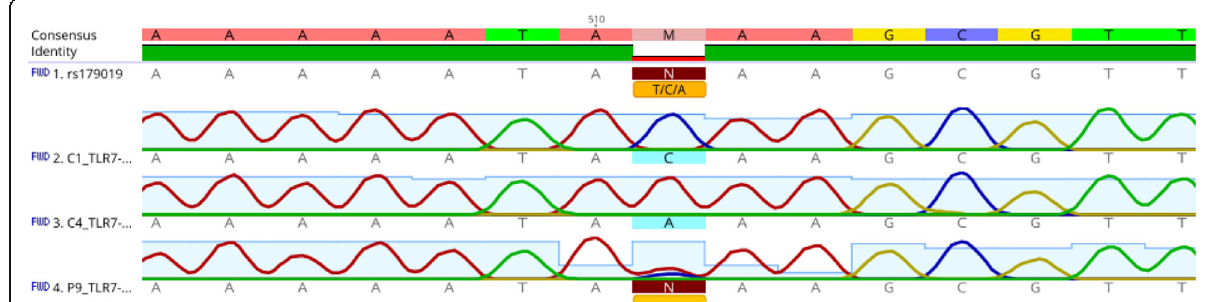
Fig. 1 DNA sequence chromatogram of TLR7 gene SNP (T/C/A: rs179019) showing three genotypes: CC (sequence 2), CA (sequence 4) and AA (sequence 3), in addition to the reference sequence (rs179019), as revealed by Geneious software (version 10.2.6)